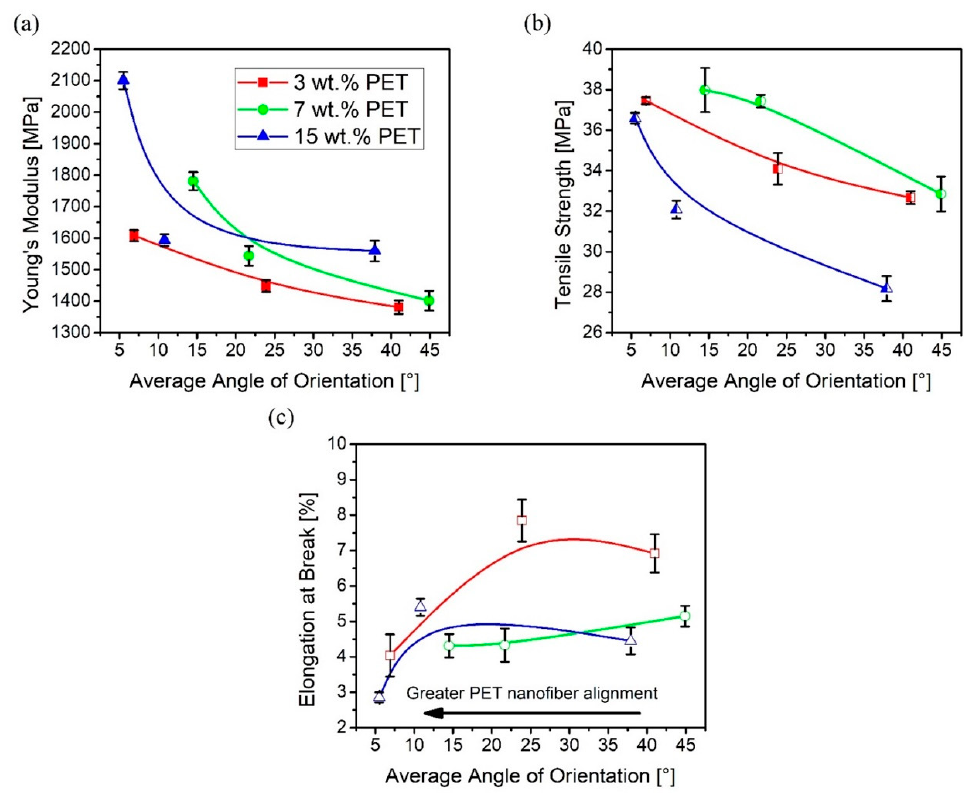
Figure 8. Variations of ( a ) elastic modulus, ( b ) tensile strength, and ( c ) elongation at break with respect to average angle of orientation along the MD. Solid lines are not trendlines but are presented to guide the eye.